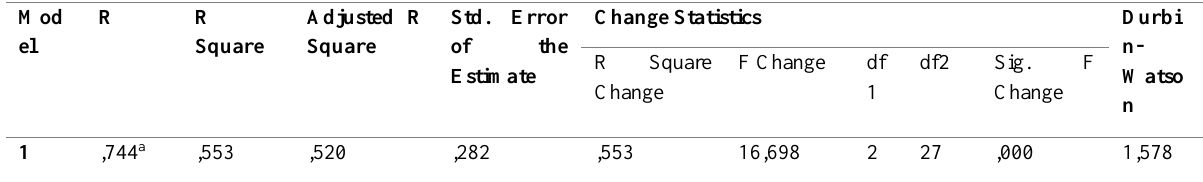
Table 3: Determination Coefficient Test Results Model Summary